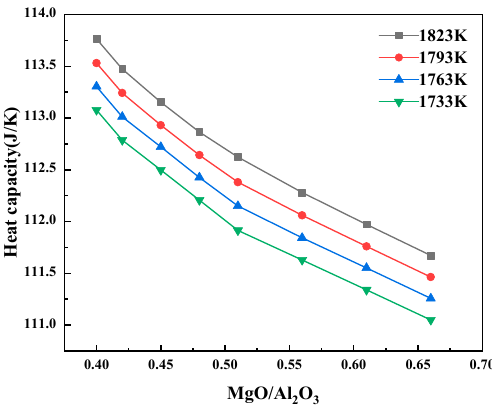
Figure 6. The heat capacity of slag with varying MgO/Al 2 O 3 .